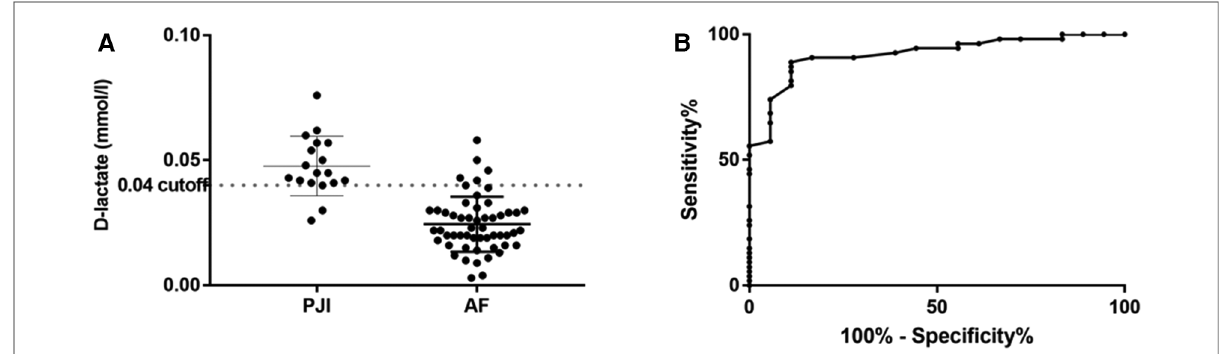
FIGURE 1 Distribution of D-lactate concentration in synovial fl uid ( A ) with corresponding receiver operation characteristic (ROC) curve ( B ).